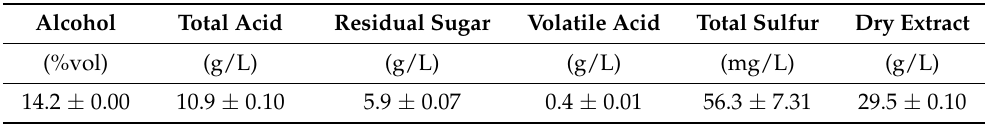
Table 2. General parameters of Beimei red wine. Alcohol Total Acid Residual Sugar Volatile